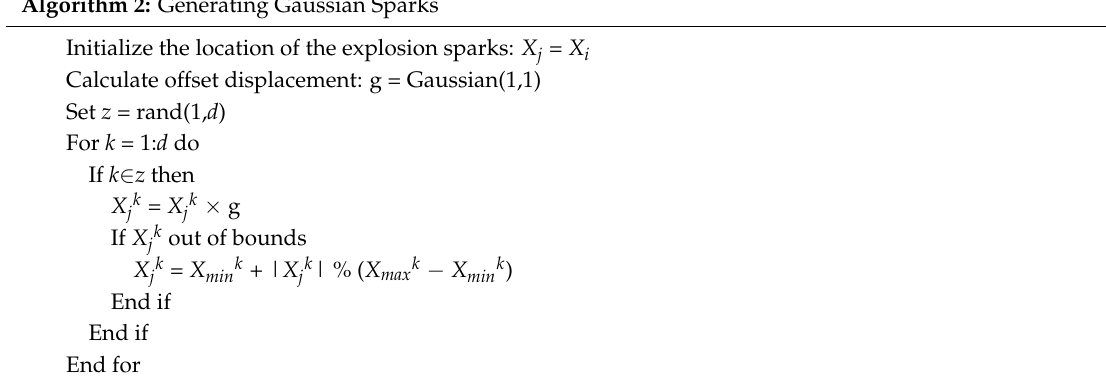
Algorithm 2: Generating Gaussian